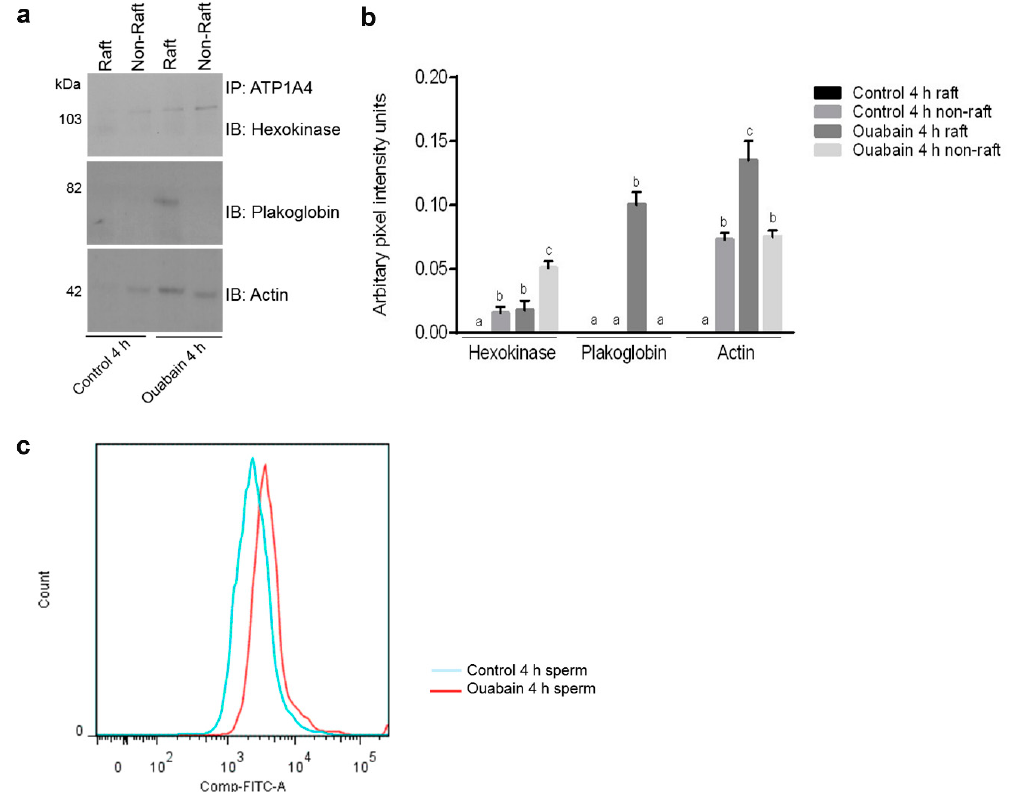
Figure 5. Validation of selected proteins that interacted with ATP1A4 during ouabain-induced